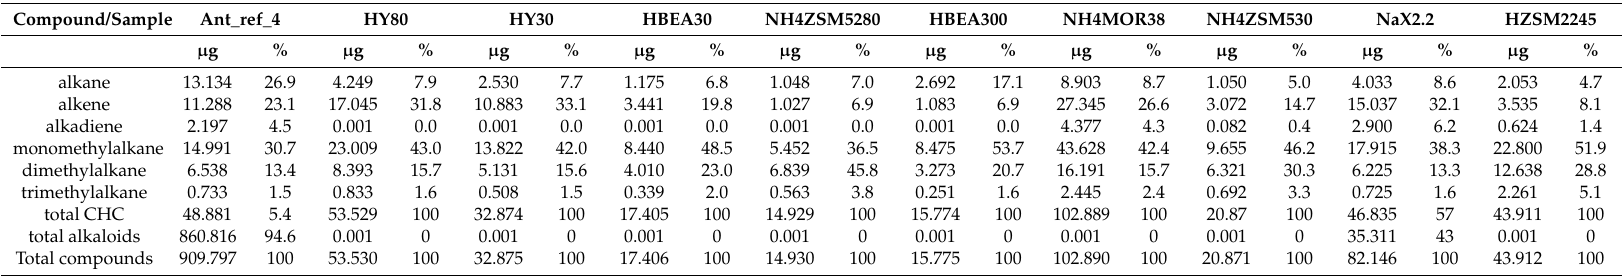
Table 2. Distribution ( µ g/500 µ L and %) of the CHC (cuticular hydrocarbons, without alkaloids) present in the hexane extract of M. pharaonis and samples extracted from zeolites exposed to M. pharaonis foragers for 1 h. Components are grouped by class. Total CHC, total alkaloids and total compounds (both CHC and alkaloids) are also provided. Compound classes which were not represented were assigned a value of 0.001 µ g (roughly 10% of the detection limit of the analysis).